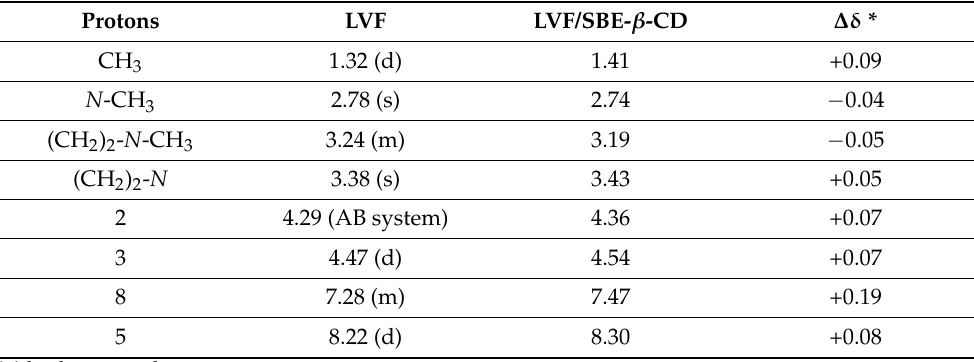
Table 1. 1 H NMR chemical shifts in δ and ∆ δ of LVF protons in free state and LVF/SBE- β -CD 1:1 complex (10 mM in D 2 O); for multiplet, doublet, or AB system, the reported δ and ∆ δ refer to the centered signal.